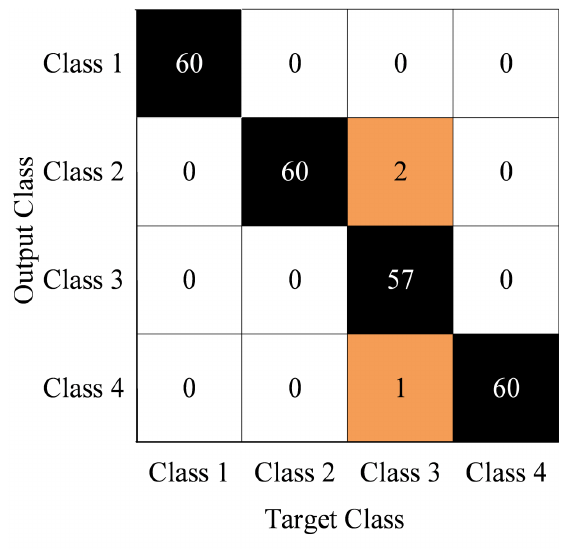
Figure 11. First diagnosis results (confusion matrix).